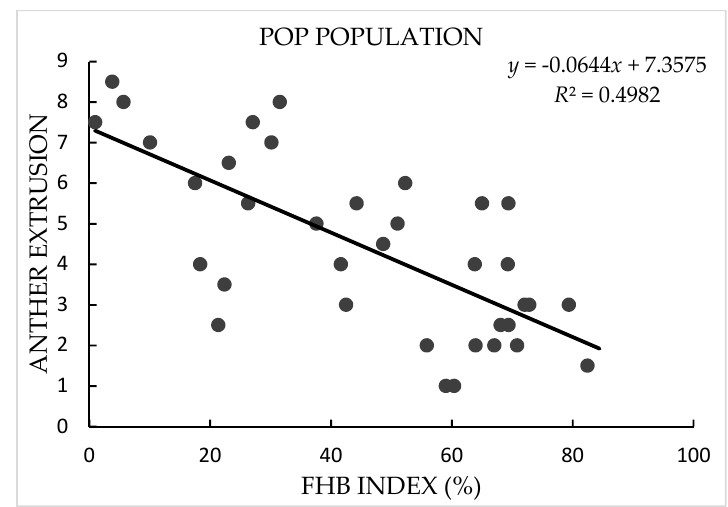
Figure 1. Scatter plots of Fusarium head blight (FHB) index against anther extrusion in “NASMA” × “IAS20*5/H567.71” (NIH), “NASMA” × “RPB709.71/COC” (NRC), 16th Fusarium head blight screening nursery (FHBSN), and “Panel of Parents” (POP) populations, using overall means. The red dot represents NASMA, and the green dot represents IAS20*5/H567.71 or RPB709.71/COC. The correlations are all significant at p < 0.0001.